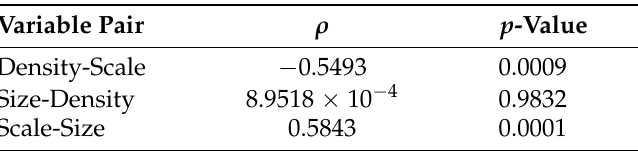
Table 1. Pearson correlation between dependent variables.